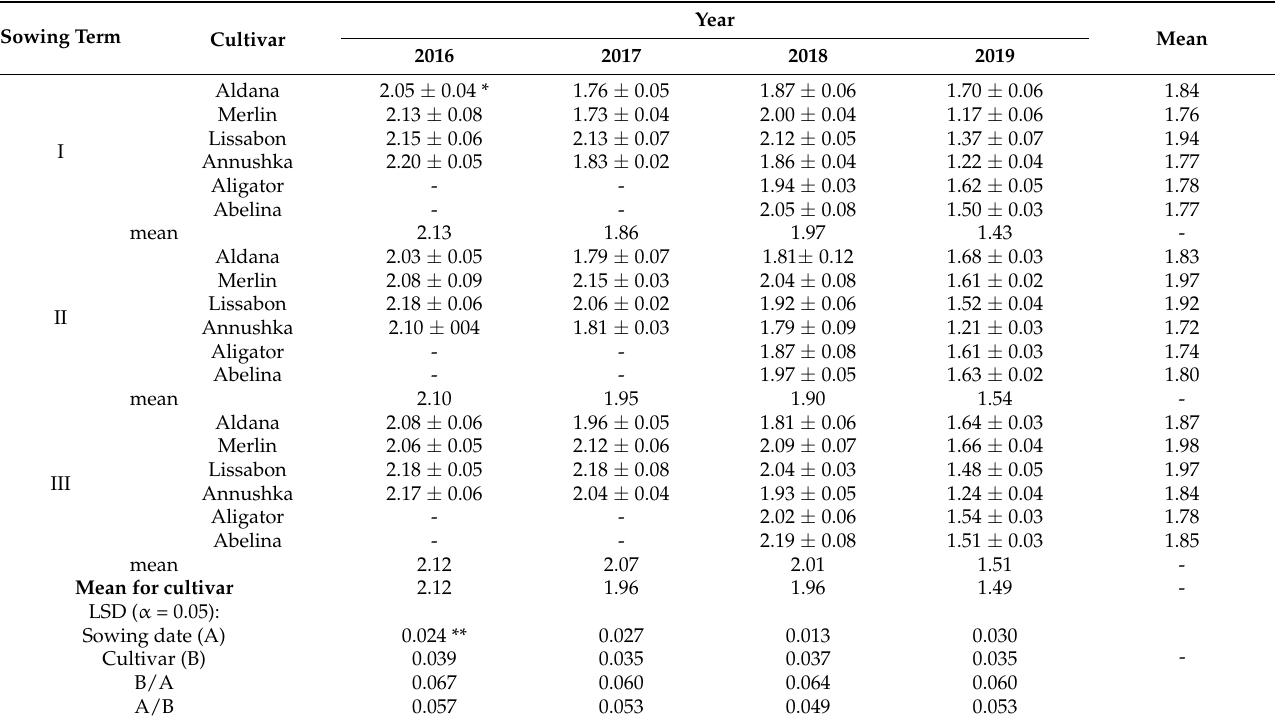
Table 11. Seeds number per pod depending on cultivar and sowing date